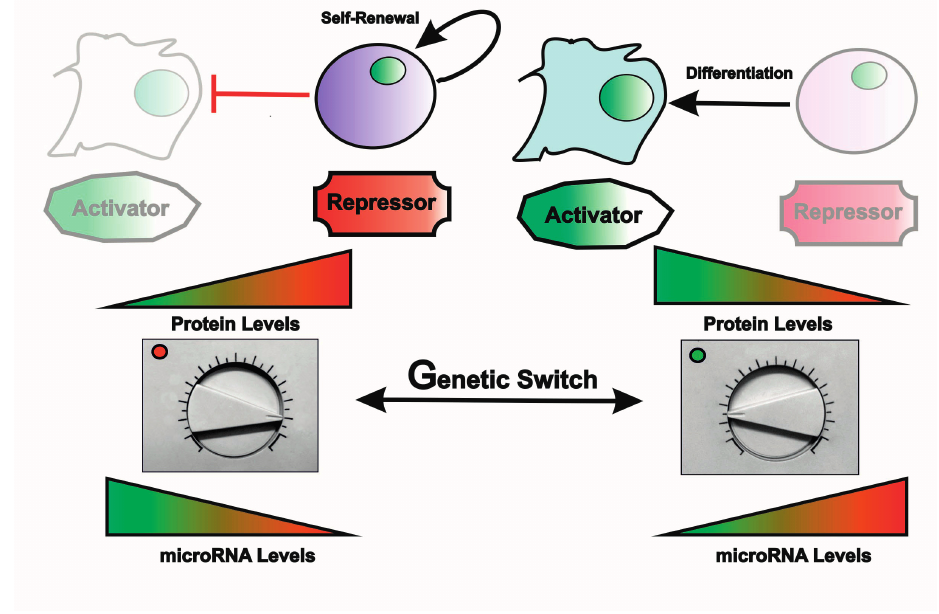
Figure 4. miRNAs are master regulators of cell lineage commitment. In response to